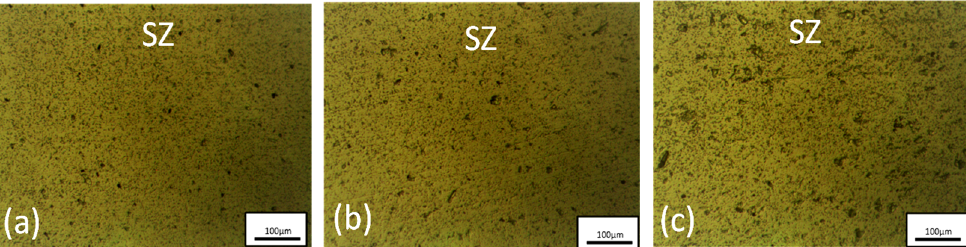
Figure 29. Microscopy image of SZ at, ( a ) 1150 rpm, ( b ) 1200 rpm, and ( c ) 1250 rpm using CTH tool at 30 mm/min feed rate.